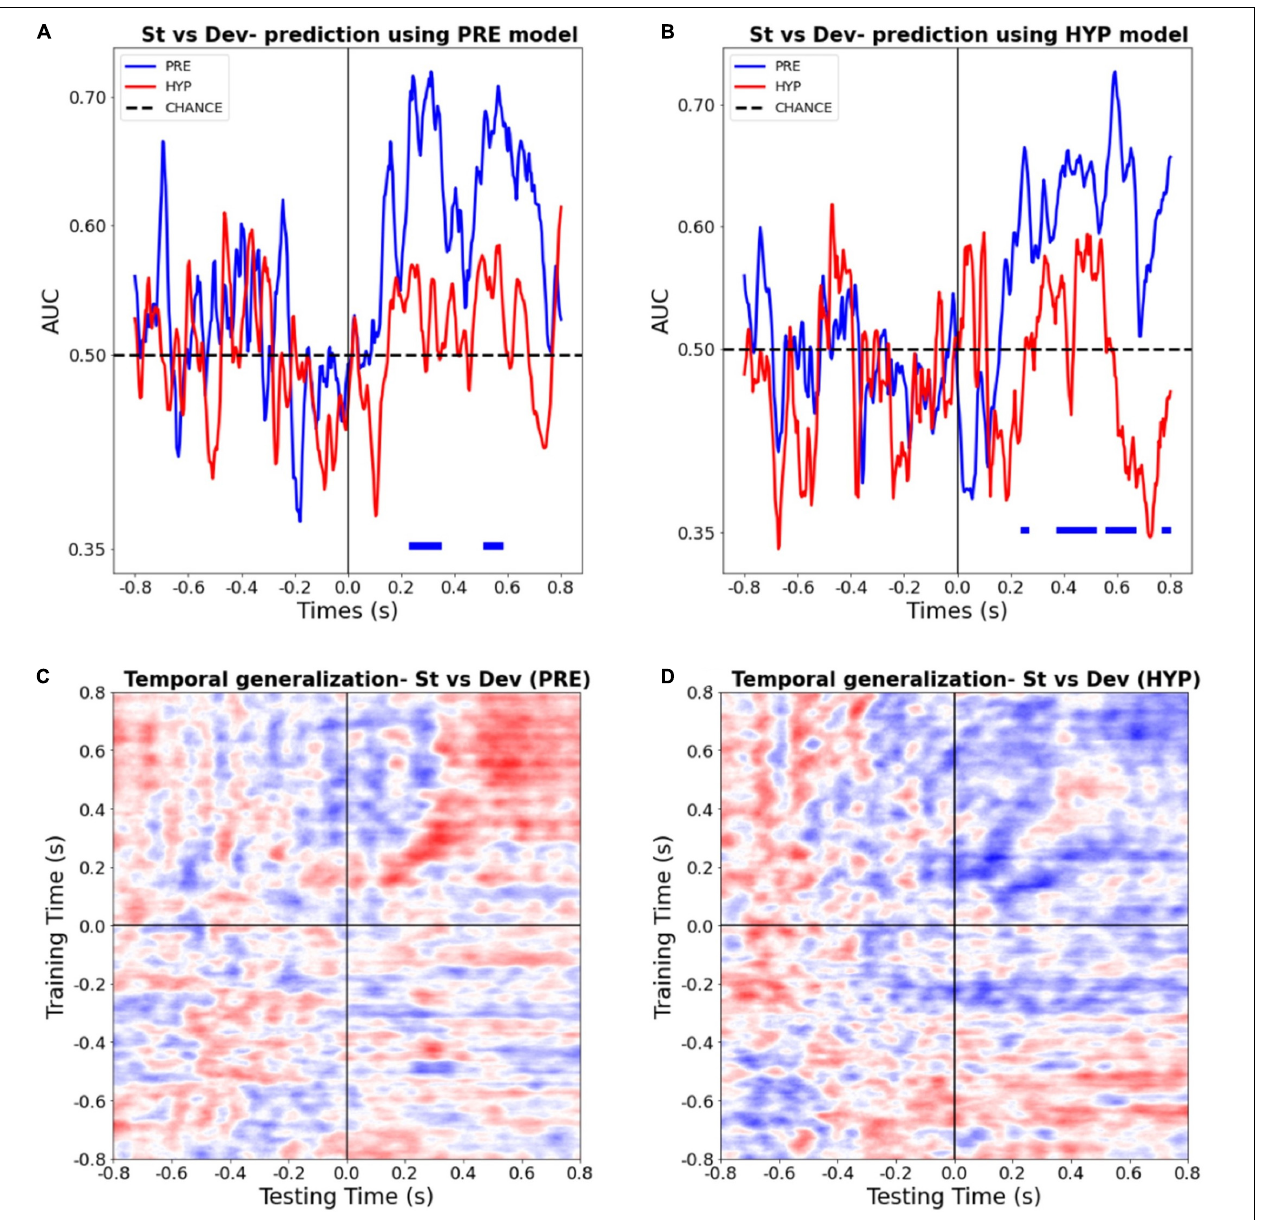
FIGURE 4 | Multivariate pattern classifiers failed to decode stimulus type (deviant vs. standard) during hypnotic deafness. (A,B) Temporal decoding. Performance (AUC) in function of time of a classifier trained to distinguish between standard (St) and deviant (Dev) trials, tested in PRE (blue) and HYP (red) conditions. The classifier was trained either with PRE (A) or HYP (B) data, and then tested in both conditions. Bottom color lines show the time intervals where the AUC was statistically significant (FDR corrected) against chance (500 permutation procedure). While above chance decoding was observed for the PRE condition, in particular in the P300 time-window, this was not the case for the HYP condition. (C,D) Temporal generalization decoding procedure. The performance (AUC) of a classifier trained to distinguish between standard and deviant trials at a given time-point was tested at all other time points, for PRE (C) and HYP (D) conditions. For PRE, a pattern already described in the literature (King and Dehaene, 2014) was observed, with an early “diagonal” shape of the decoding, suggestive of a series of transient, unconscious stages of processing, and a late “square-shaped” pattern of the decoding, suggestive of a sustained stage of processing, previously associated with conscious access. For HYP, while the first component was preserved, we didn’t observe the late square-shaped component of the decoding pattern, suggesting a specific abolishment of the late conscious stage of